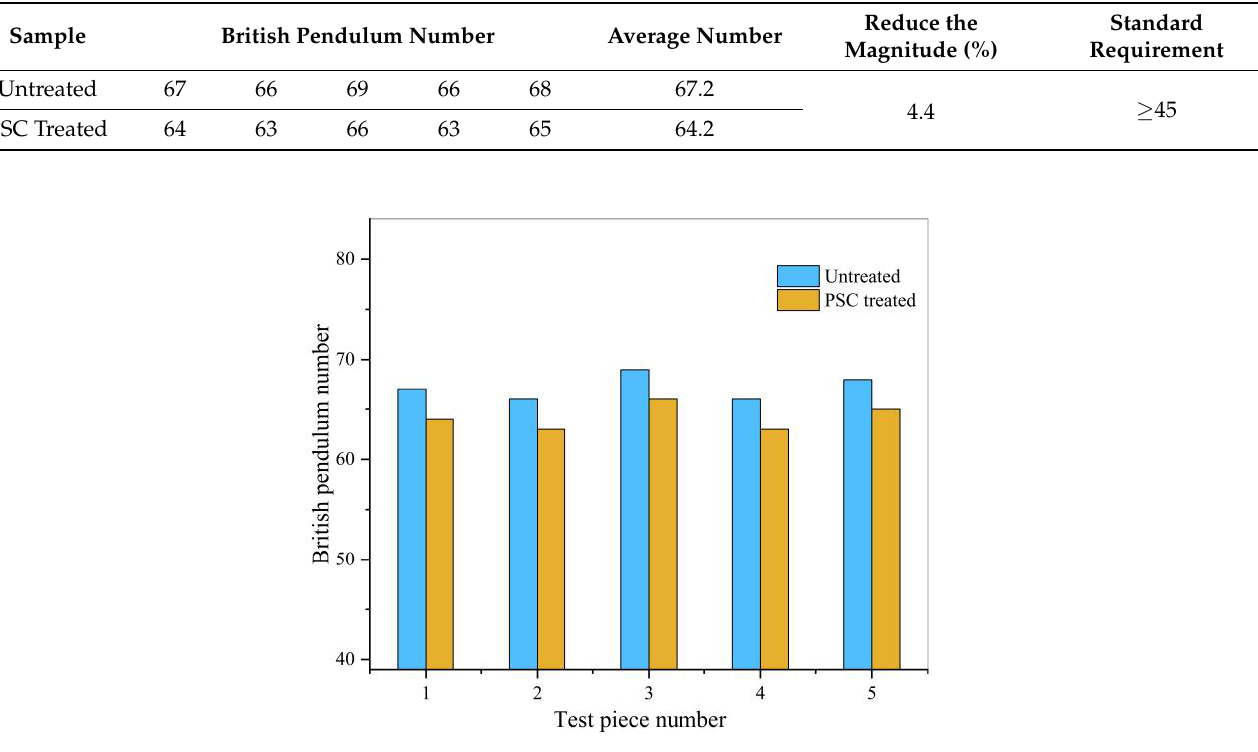
Figure 10. Pendulum number test results. Table 6. Pendulum number test results.